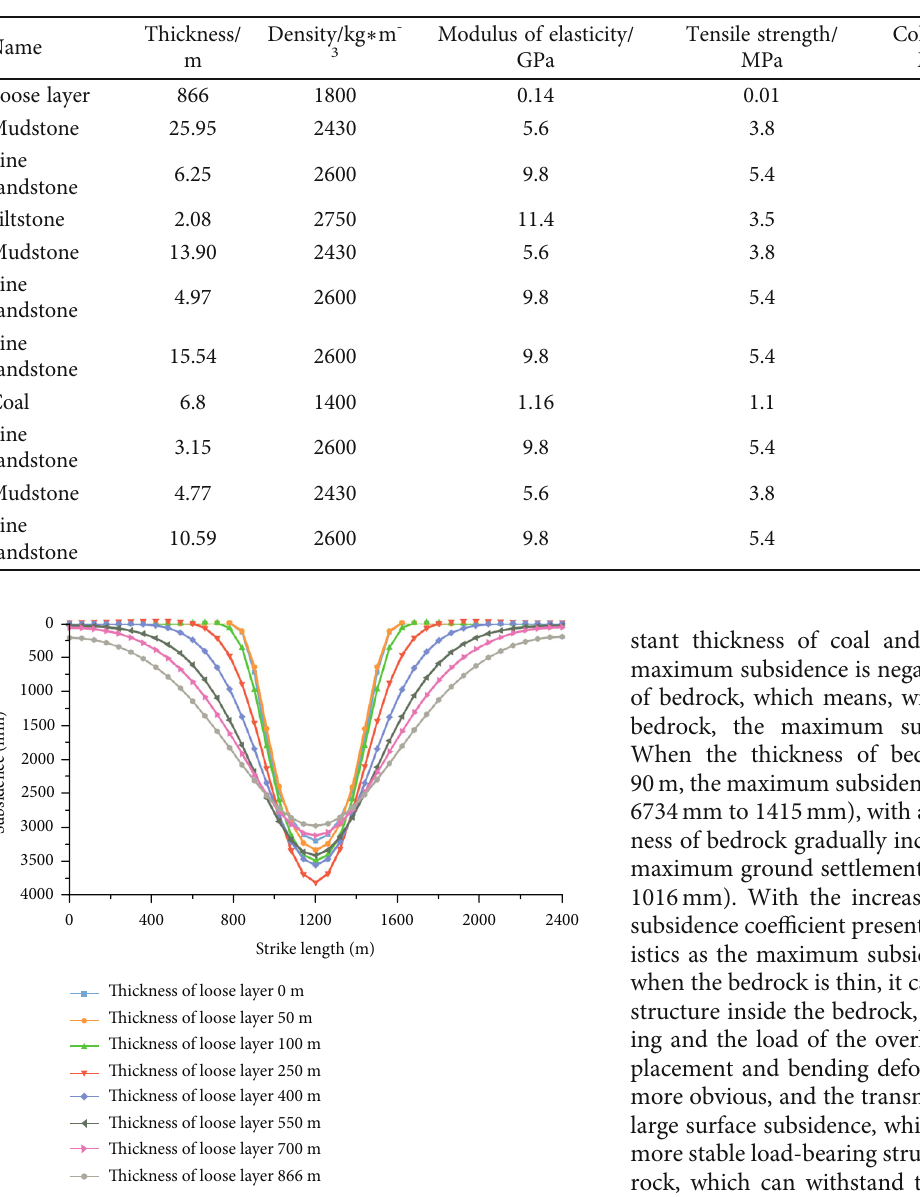
Figure 6: Surface subsidence curve in strike direction with di ff erent thickness of loose